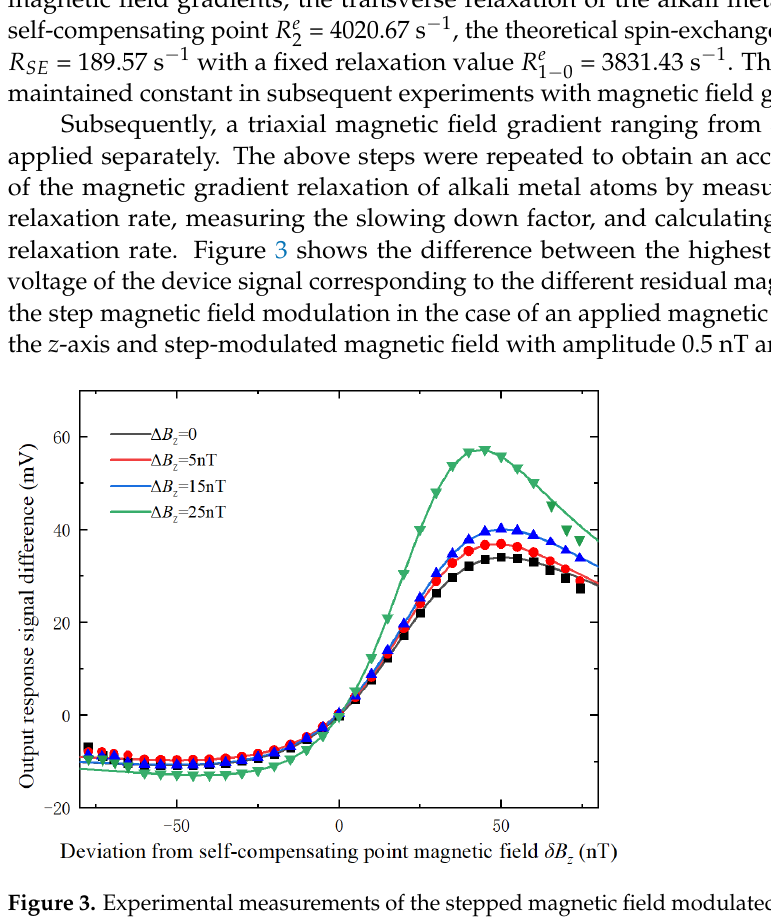
Table 2. Experimental results of magnetic gradient relaxation of alkali metal atoms in coupled spin ensemble under applied x -axis magnetic gradient.